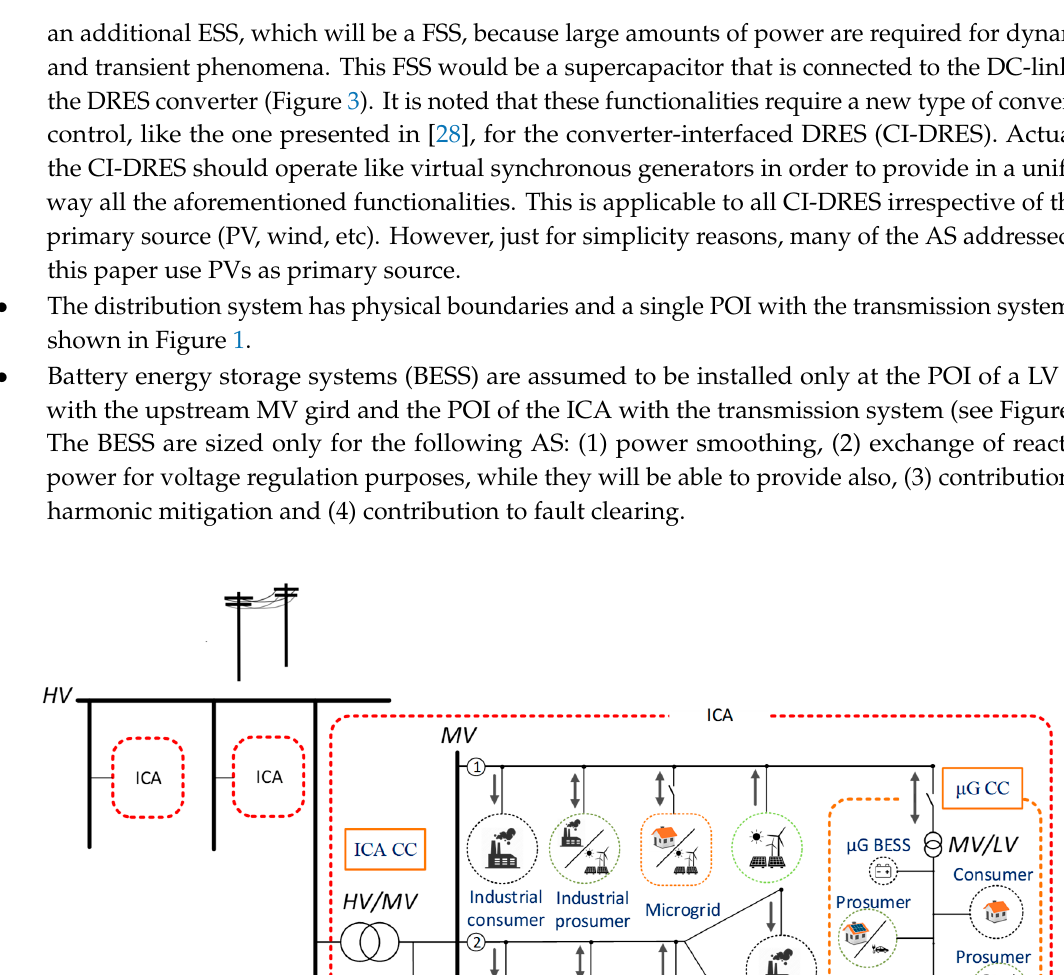
Figure 2. Proposed AS and their categorization [18,27,28] .